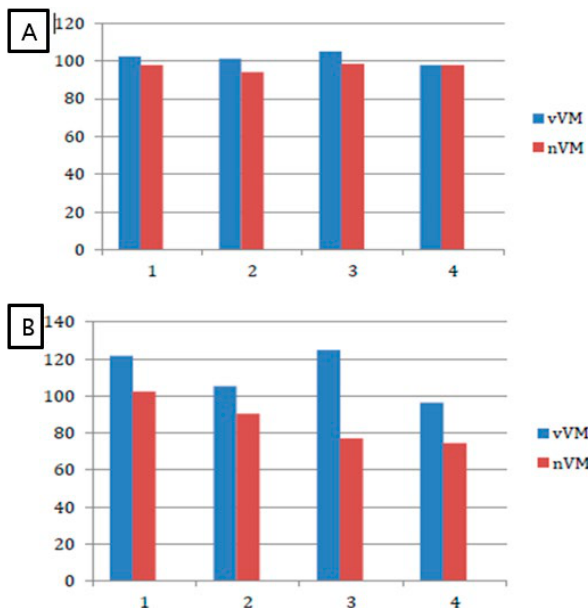
Figure 8A. Variation of water loss during drying of Spruce ( Picea abies ) samples, comparing the felling dates occurring in the 3.5 days running up to the Full Moon (vVM), with those of felling occurring during the 3.5 days after the Full Moon (nVM), for the months of November 2003 (1), December (2), January 2004 (3) and February (4). The samples from before the Full Moon of Novem- ber, December and January lost slightly more water than those from fellings performed after the Full Moon. Values calculated from the general mean. Figure 8B. Variation of capillary water absorption by the dried Spruce ( Picea abies ) samples, comparing the felling dates occurring in the 3.5 days running up to the Full Moon (vVM), with those of felling occurring during the 3.5 days after the Full Moon (nVM), for the months of November 2003 (1), December (2), January 2004 (3) and February (4). The samples from before the Full Moon of November, December, January and February absorbed considerably more water than those coming from fellings performed after the Full Moon. Values calculated from the general